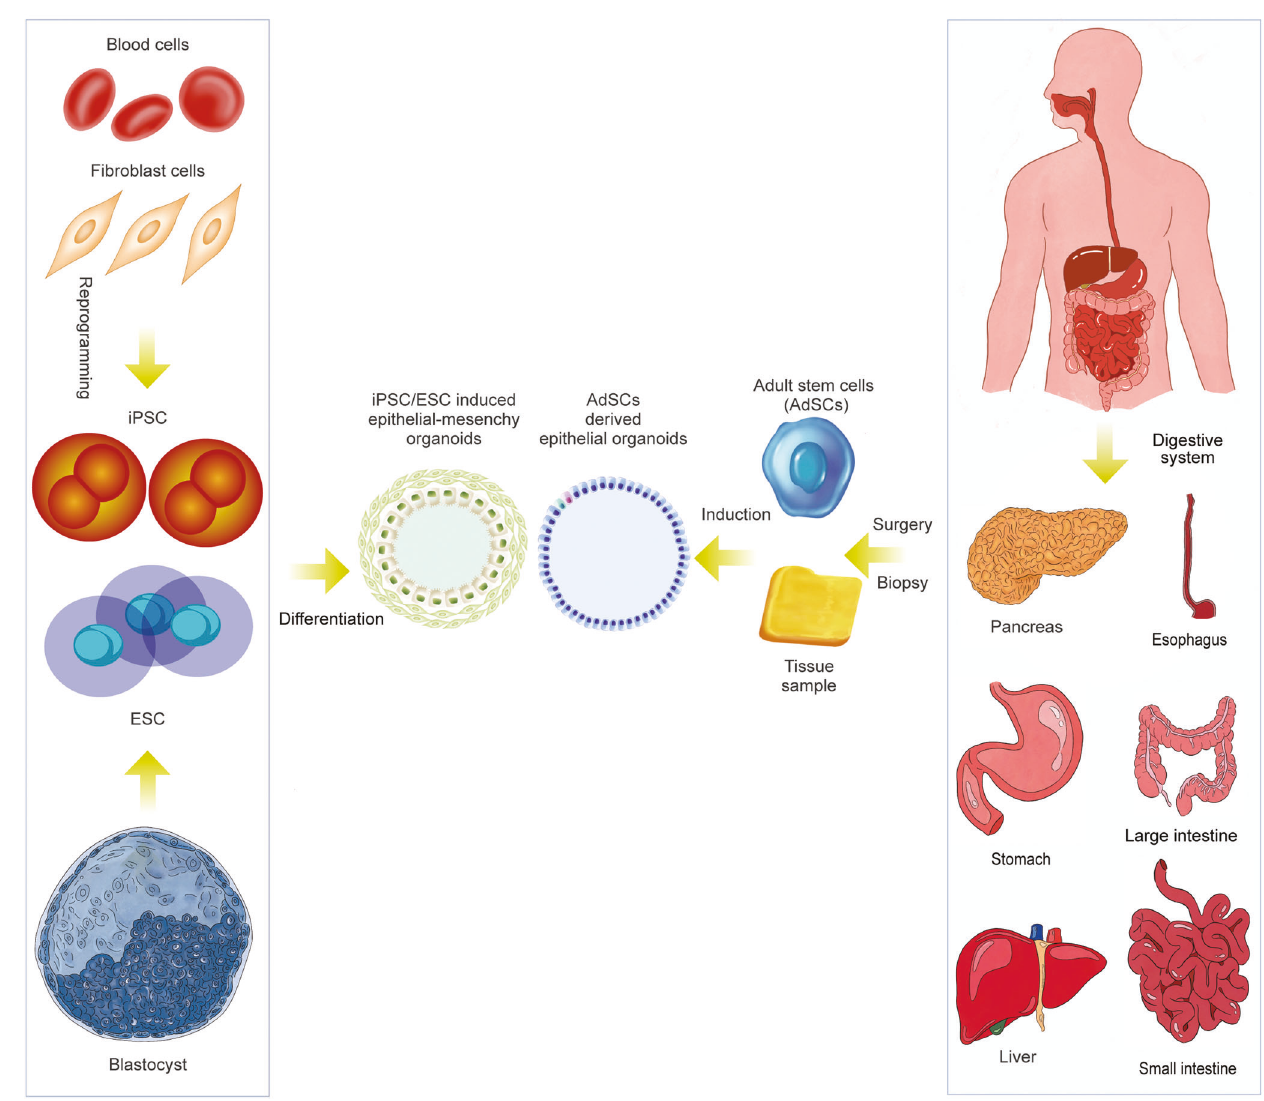
Fig. 1 Schematic diagram summarizing the generation of digestive organoids and the manner of cell differentiation. Organoids derived from isolated epithelial stem cells and tissue samples, reprogramming of skin fi broblasts and blood cells into pluripotent stem cells (PSCs). (Induction involves germ-layer speci fi cation (endoderm) and subsequent induction and maturation by speci fi c growth factor